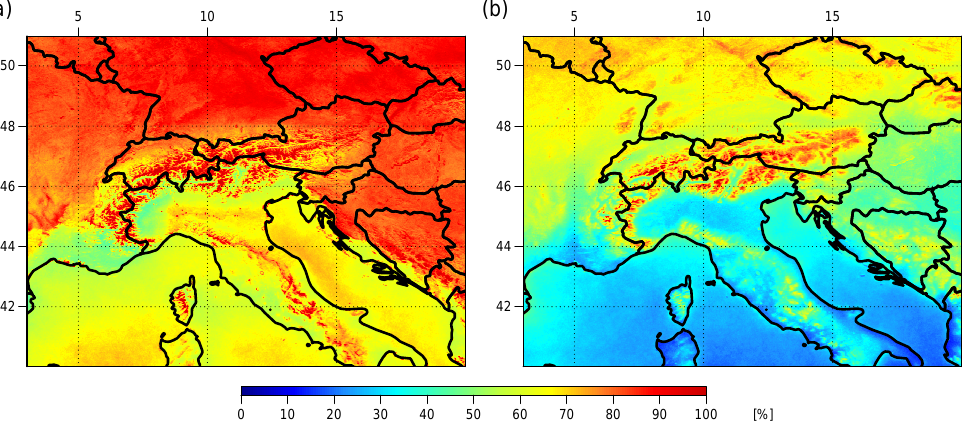
Figure 2. Winter (December, January, February) (a) and summer (June, July, August) (b) averaged cloud occurrences in the MODIS-Aqua L3U data set, years